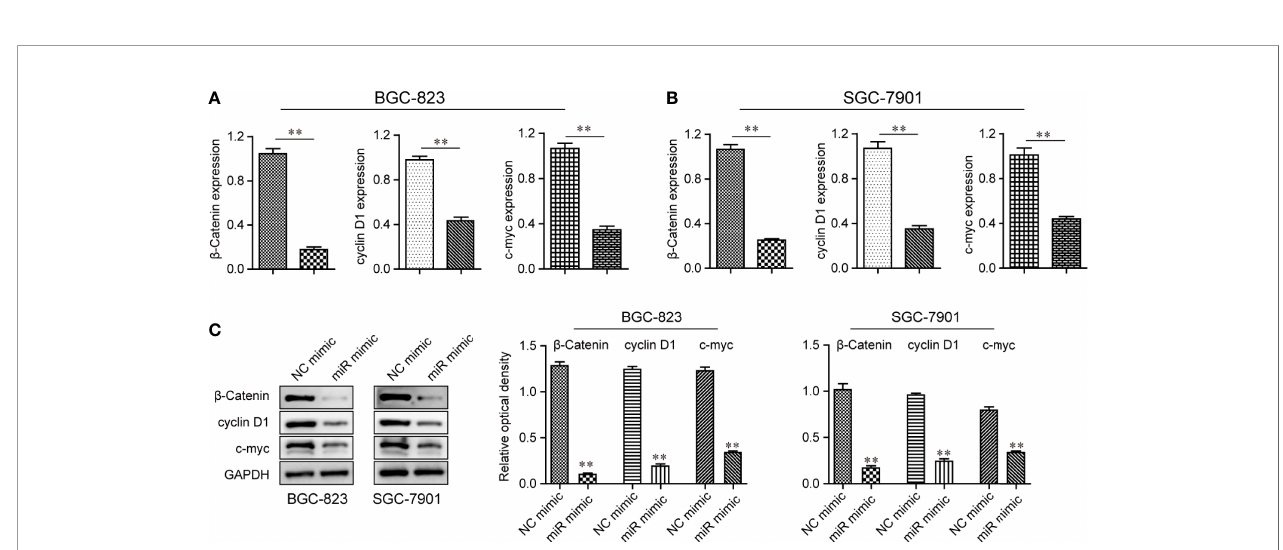
FIGURE 7 | The activity of the Wnt/ b -catenin signaling pathway was repressed by up-regulation of miR-1224 in BGC-823 and SGC-7901 cells. (A, B) The qPCR assays examined the mRNA levels of b -catenin, cyclin D1, and c-myc in BGC-823 and SGC-7901 cells. (C) The protein expressions of c-myc, cyclin D1, and b - catenin in BGC-823 and SGC-7901 cells were reduced when the cells were transfected with miR-1224 mimics. ** p < 0.01. Experiments were repeated three times with three